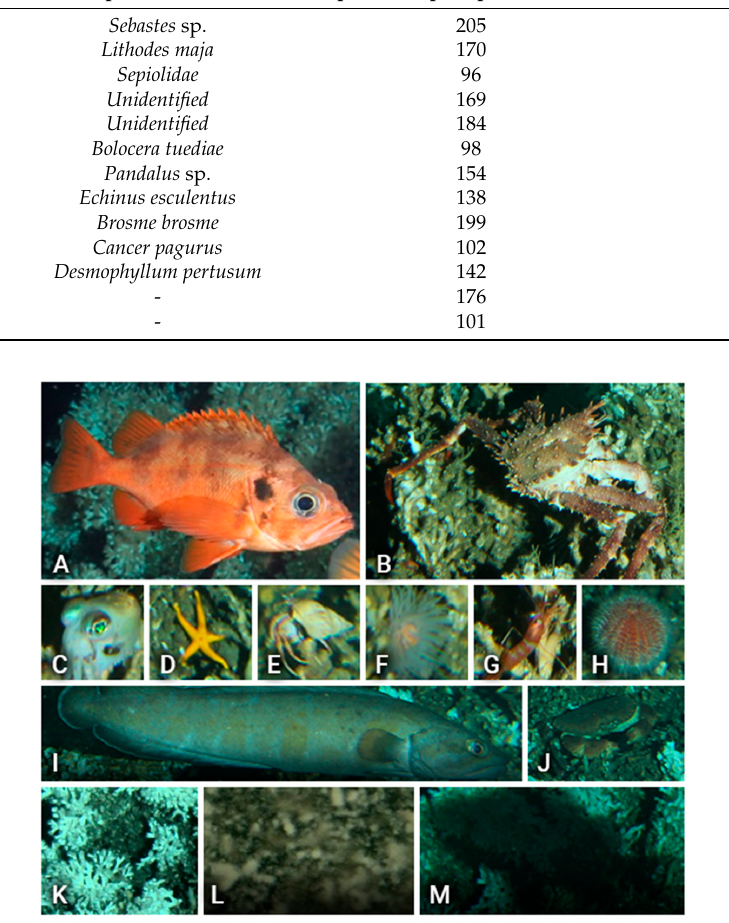
Figure 2. An example of video-detected species used for building the training dataset for reference at automated classification: ( A ) Rockfish ( Sebastes sp.), ( B ) king crab ( Lithodes maja ), ( C ) squid ( Sepiolidae ), ( D ) starfish, ( E ) hermit crab, ( F ) anemone ( Bolocera tuediae ), ( G ) shrimp (Pandalus sp.), ( H ) sea urchin ( Echinus esculentus ), ( I ) eel-like fish ( Brosme brosme ), ( J ) crab ( Cancer pagurus ), ( K ) coral ( Desmophyllum pertusum ), and finally ( L ) turbidity, and ( M ) shadow.